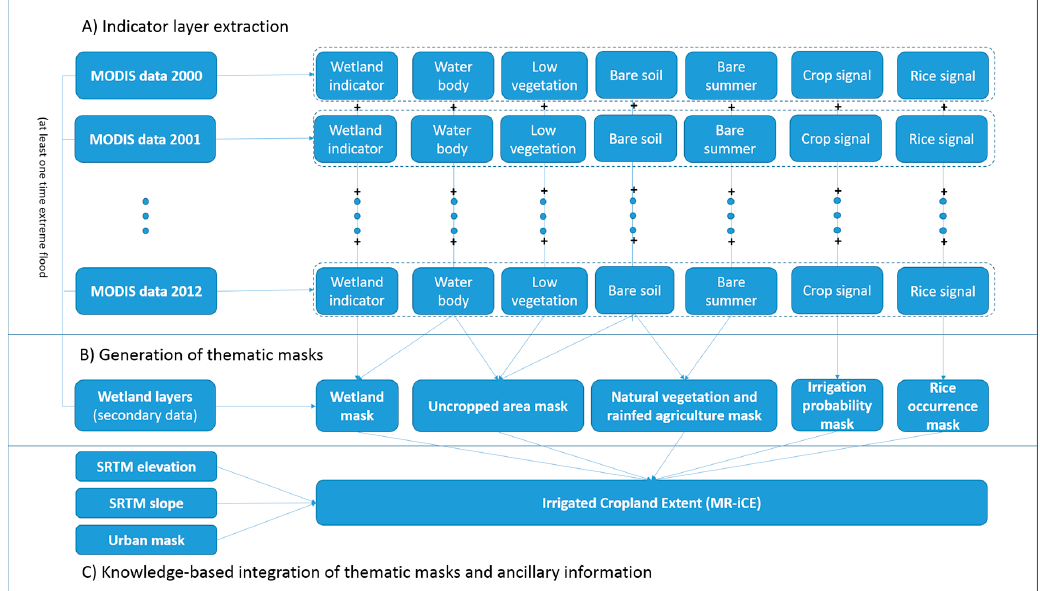
Figure 5. Scheme of procedure for the derivation of MR-iCE. The upper part ( A ) outlines the analysis of annual MODIS time series, i.e., the extraction of indicator layers, from which thematic masks were generated as shown in the middle part ( B ); The lower part ( C ) outlines the knowledge-based integration of the thematic masks for extracting the irrigated cropland extent (MR-iCE).